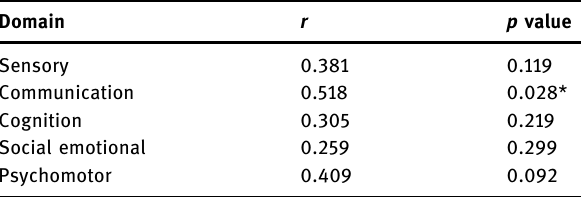
Table 9: Pearson correlations between months in the study and